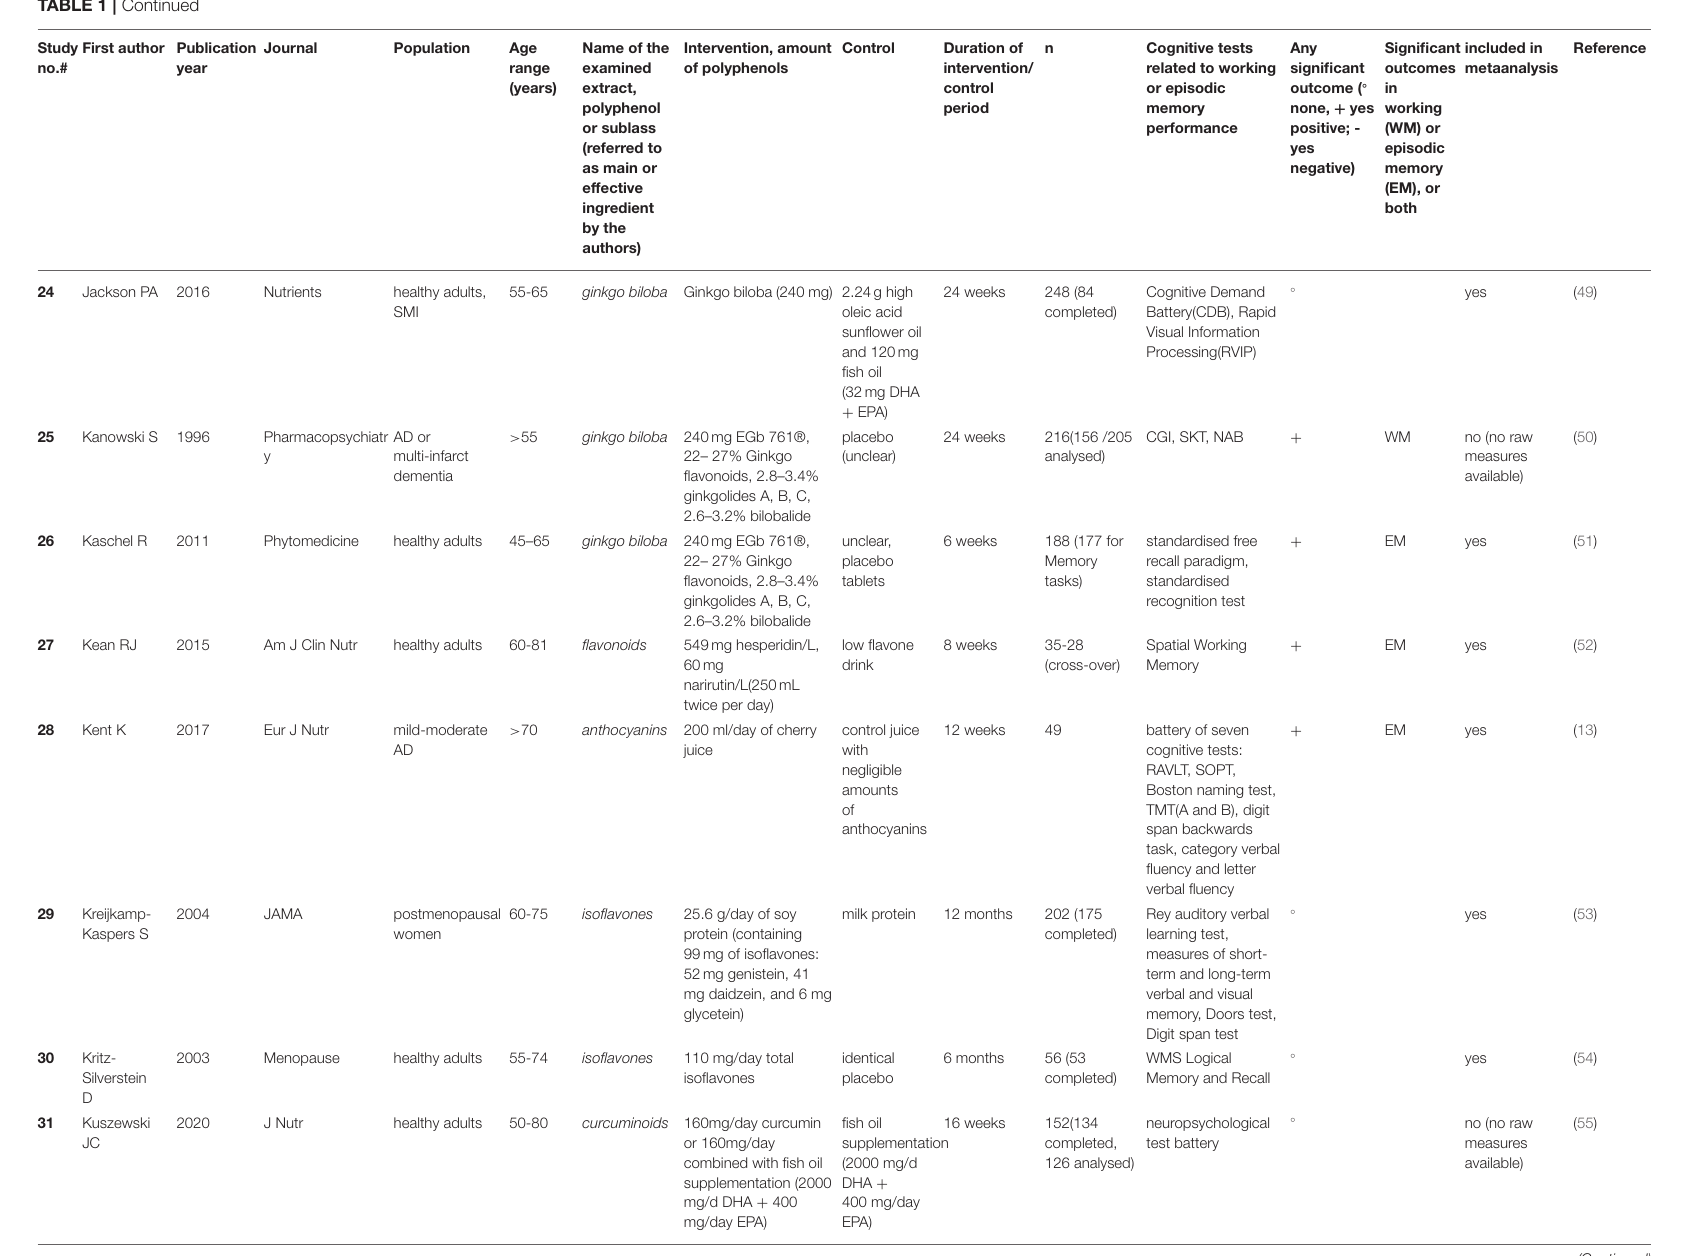
battery of seven cognitive tests: RAVLT, SOPT, Boston naming test, TMT(A and B), digit span